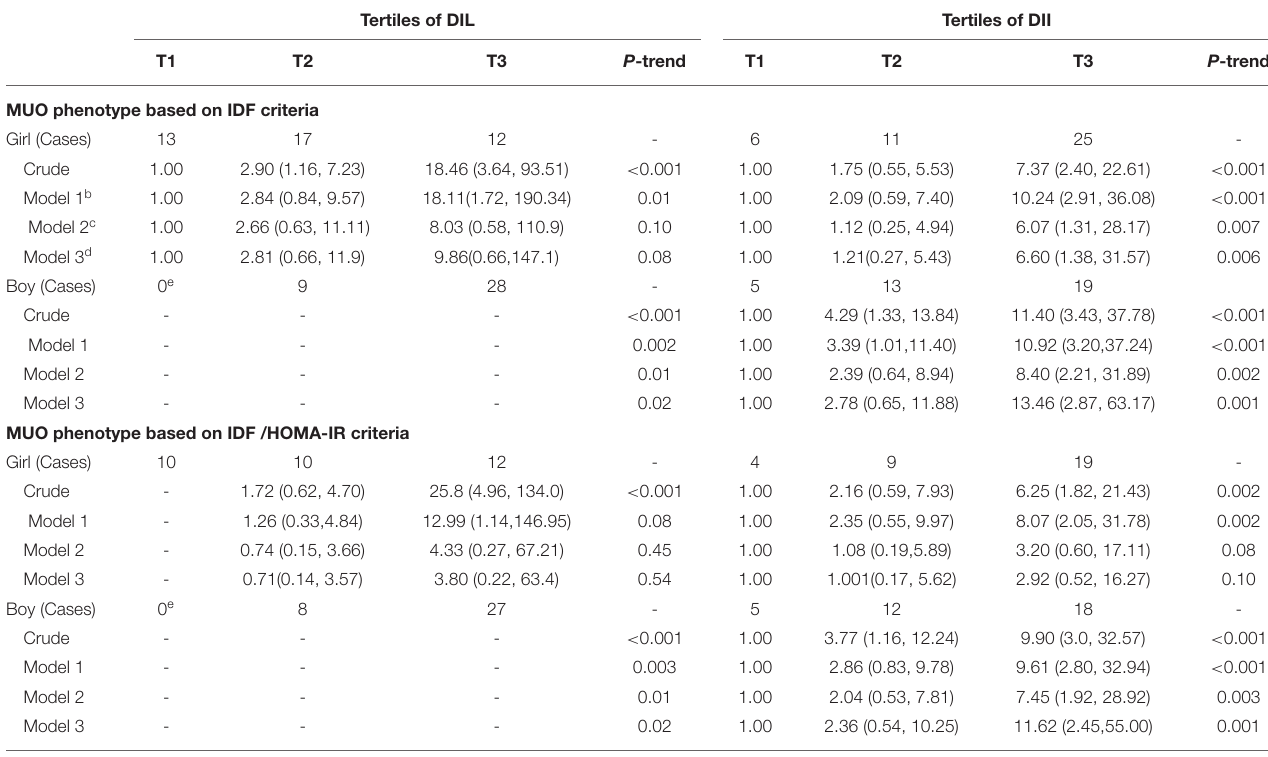
TABLE 5 | Multivariate adjusted odds ratio (OR) and 95% CI for MUO across tertiles of energy-adjusted DIL and DII, stratified by sex a . Tertiles of DIL Tertiles of DII T1 T2 T3 P -trend T1 T2 T3 P